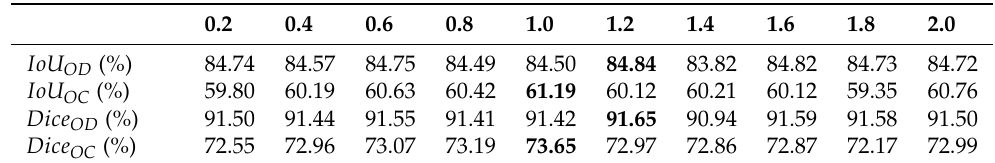
Table 4. Illustration of the varied performance of the proposed method on the RIM-ONE_r3 test set with different weights of the shape constraint loss function.